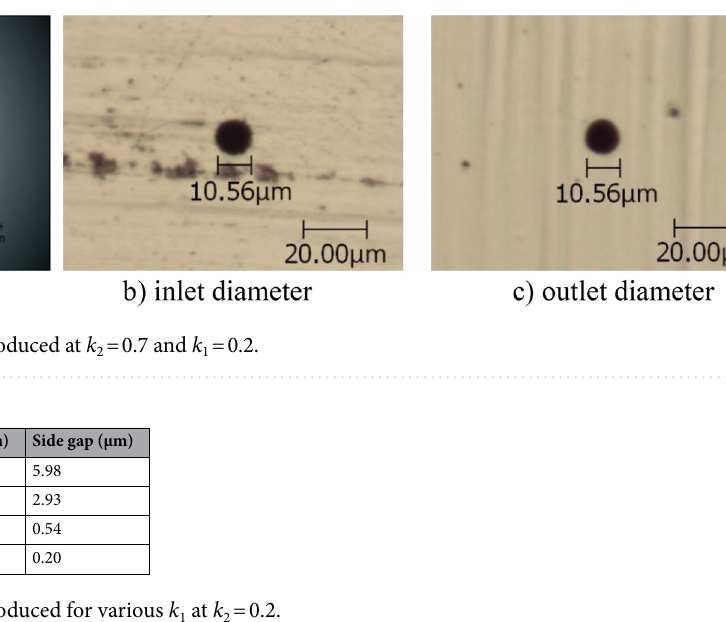
Table 3. Micro holes produced for various k 1 at k 2 = 0.2.